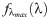
Graphs of exact pdf fλmax(λ) and of g(λ) for W˜(3,13).